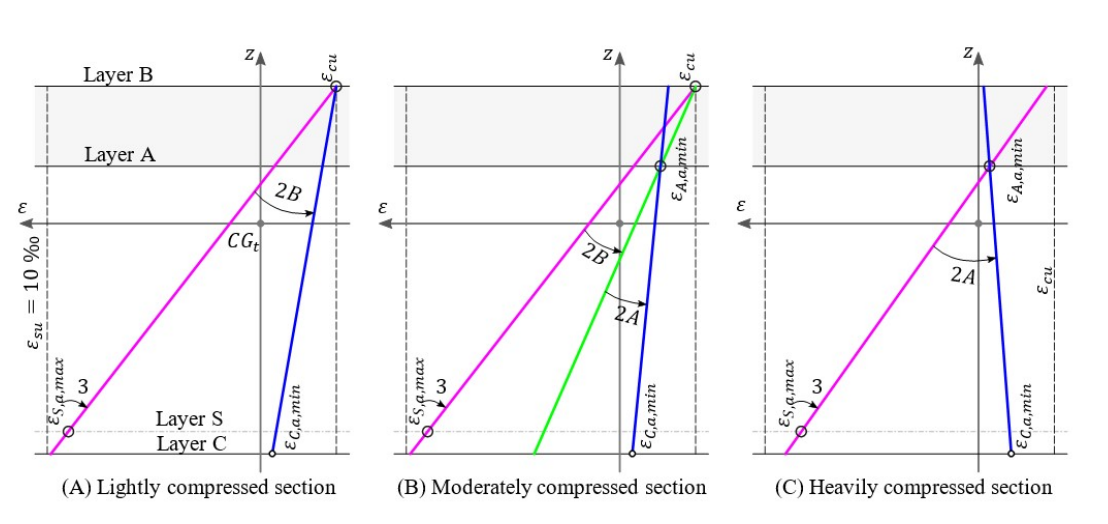
Figure 9. Strain regions in ULS in the additional